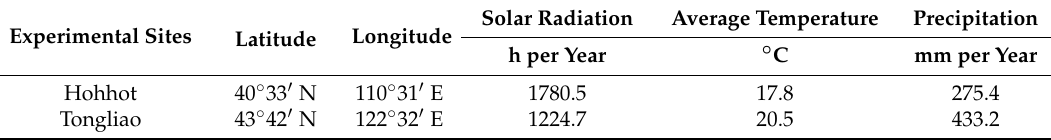
Table 2. Weather condition of 2015 in Hohhot and Tongliao.